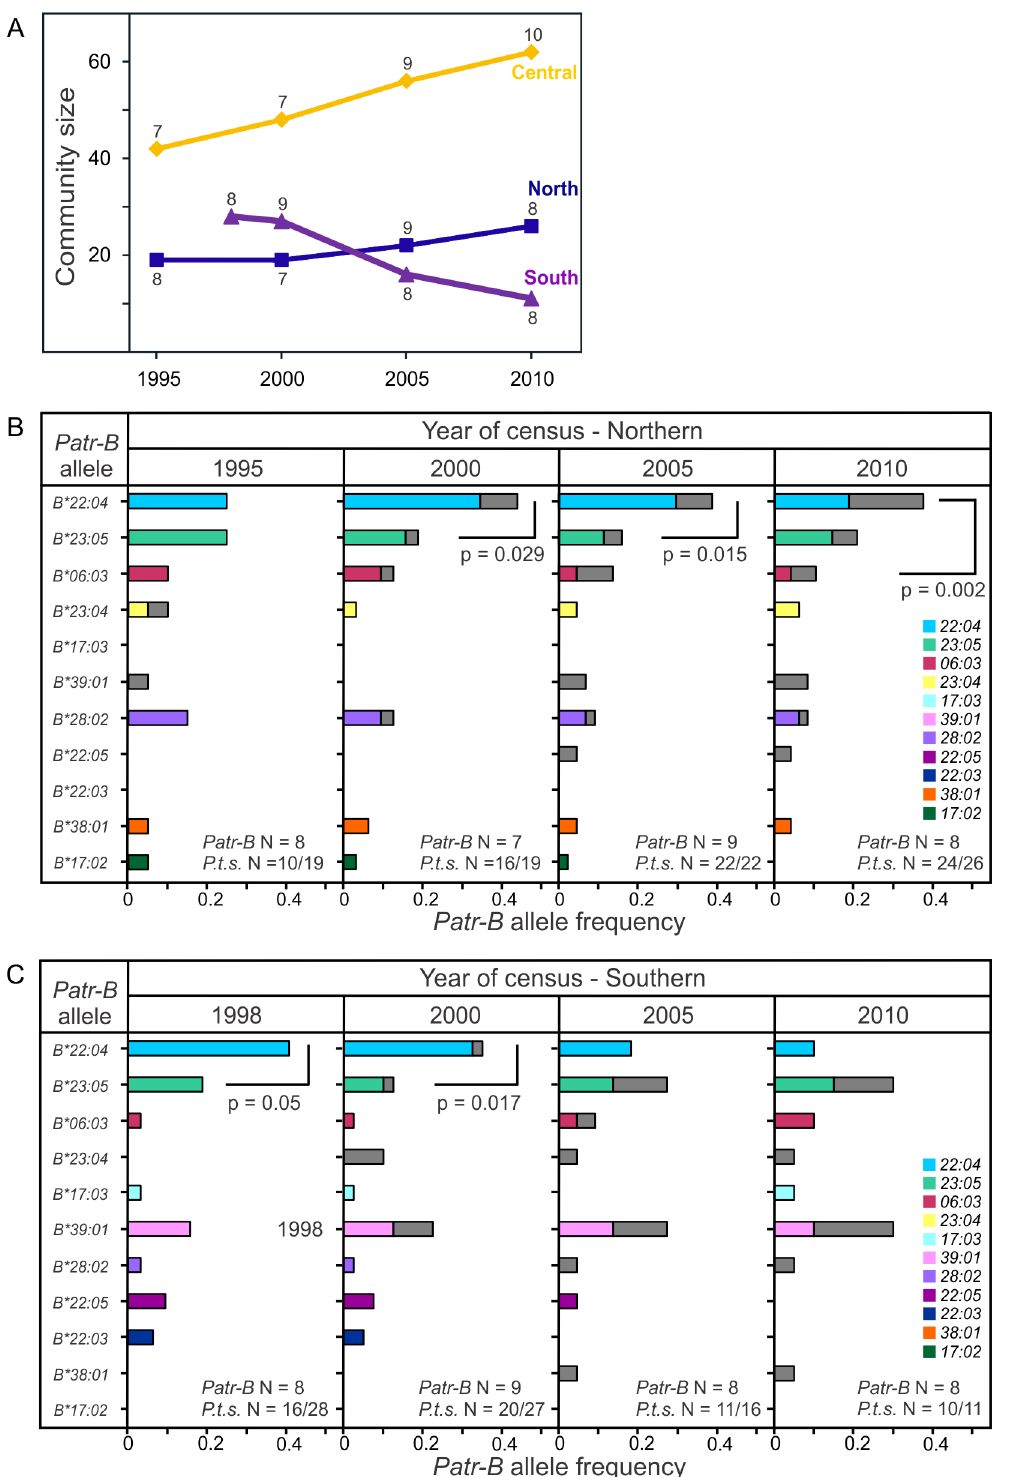
Fig 9. Population dynamics of Patr-B in the three communities of Gombe chimpanzees. (A) Shows changes in population size for the central (orange), northern (blue), and southern (purple) communities between the years 1995 and 2010. The earliest census year was 1998 for the southern community. The number of Patr-B alleles is given at each time point: diamonds for the central, rectangles for the northern, and triangles for the southern community. (B) Shows the temporal variation of Patr-B allele frequencies and the contribution of immigrant females and their offspring to the northern Gombe